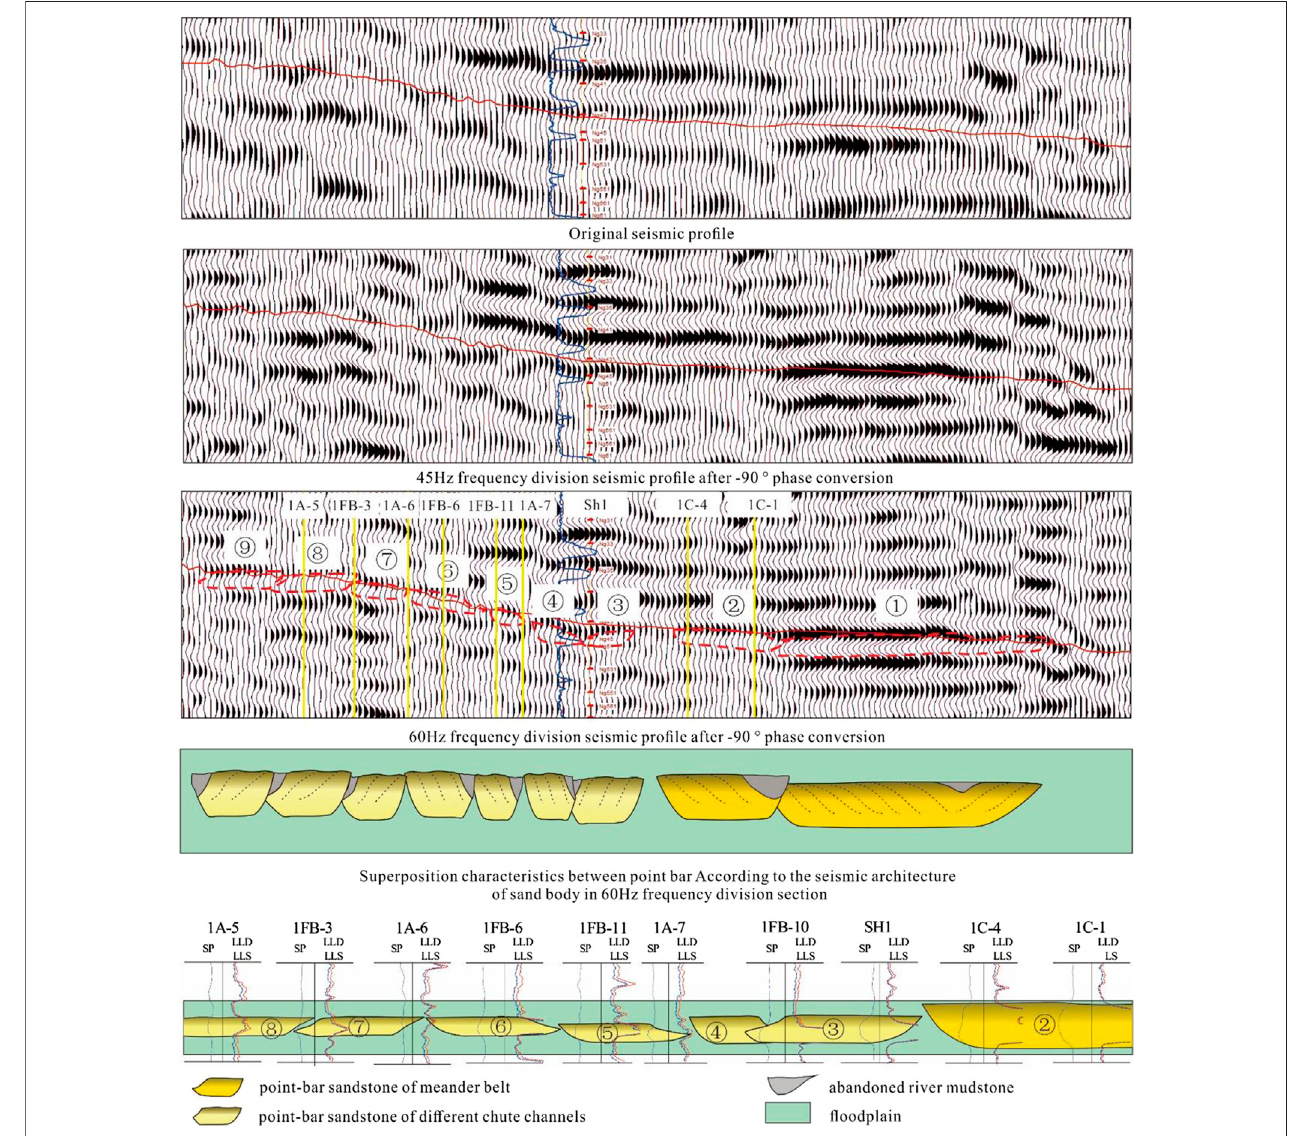
FIGURE 10 | Architectural characteristics of typical point bar in Ng45 sub-layer, seismic and logging interpretation pro fi le, and results.